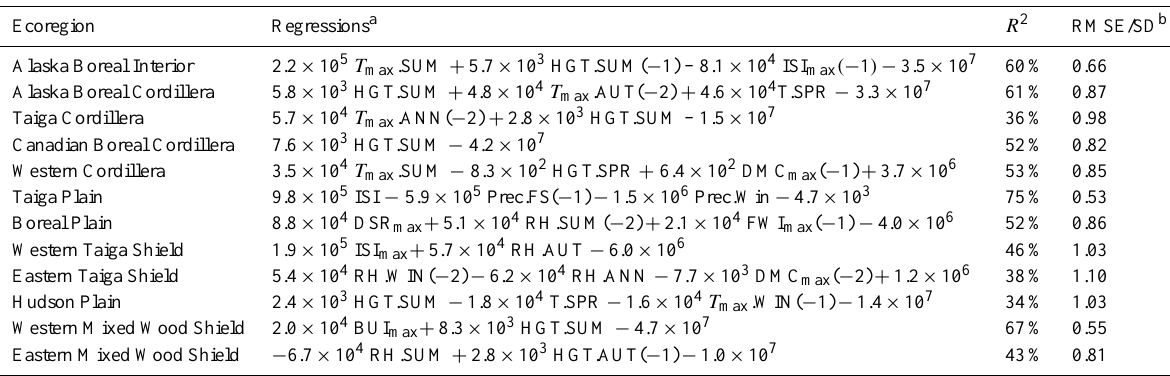
Table 2. Regression fits a for each aggregated ecoregion. Ecoregion Regressions